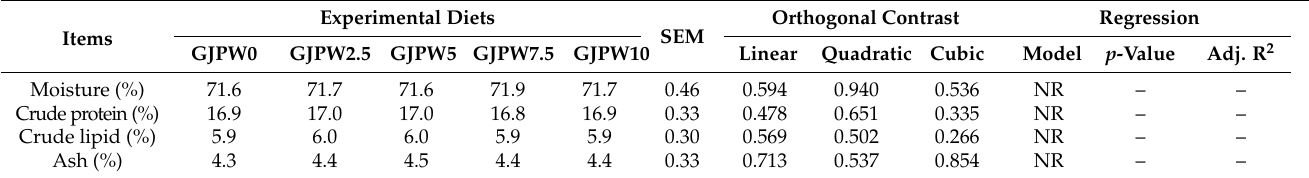
Table 5. Proximate composition (%, wet weight basis) of whole-body of juvenile rockfish fed with different levels of garlic juice processing waste (GJPW) inclusion in